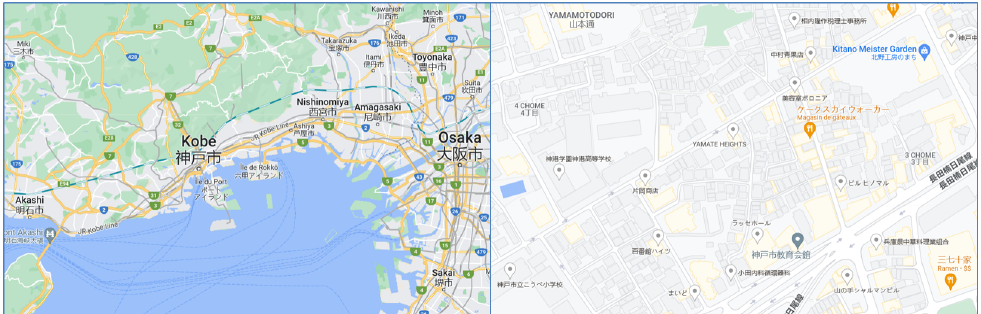
Figure 1. Maps of Kobe at different scales from Google Maps, showing the differences that cause the desert fog